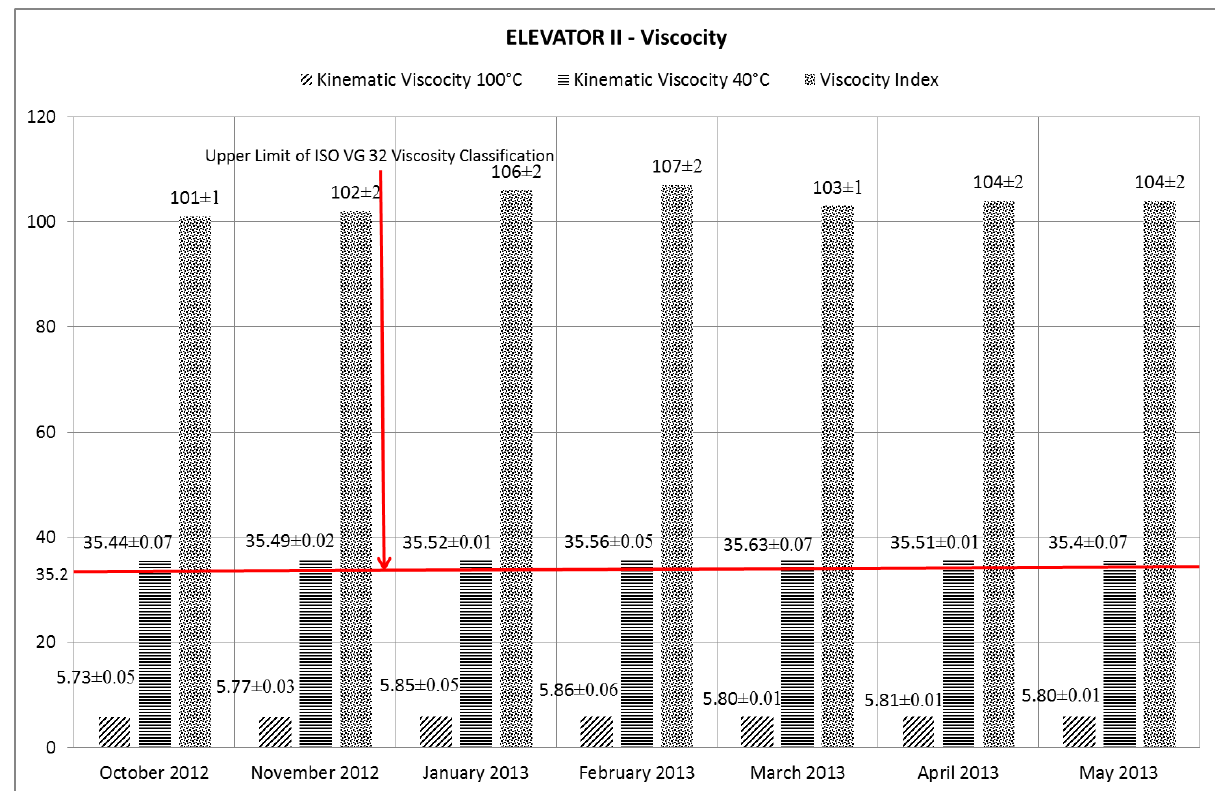
Figure 2. Viscosity in Elevator II.